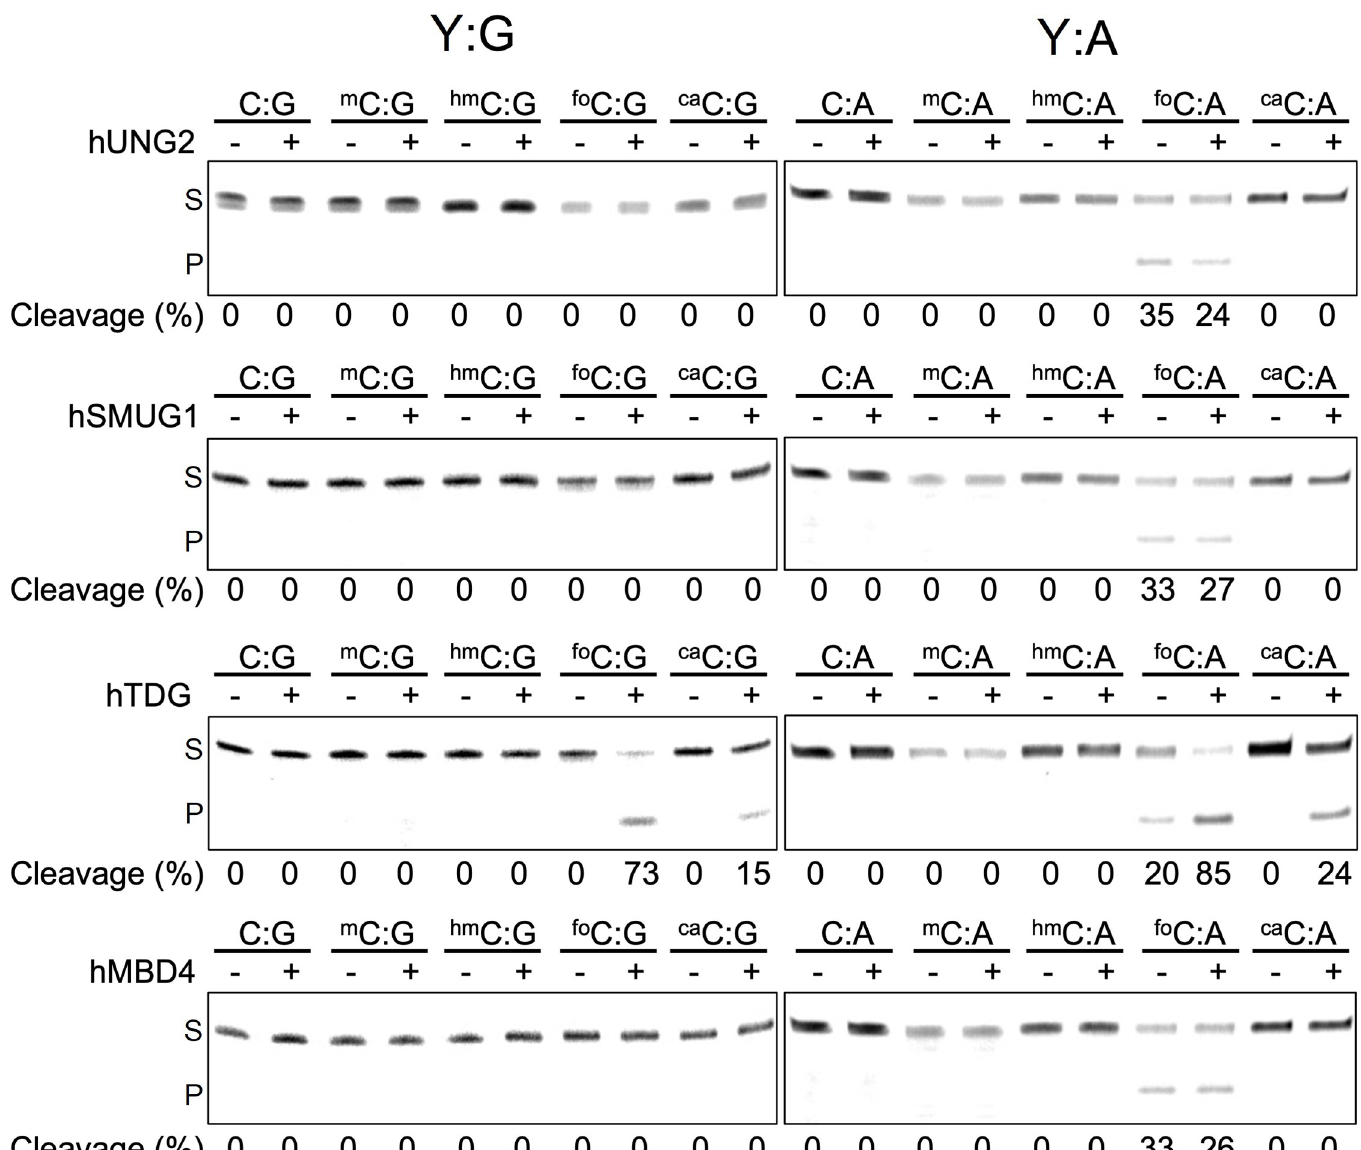
Fig 4. The excision specificity of human uracil family glycosylases for a series of 5-substituted cytosine analogs (Y) paired with G (left) or A (right). FAM-labelled oligonucleotide duplexes (2.5 pmol) in buffer appropriate for each enzyme were incubated with a glycosylase at 37˚C for 1 h. Duplexes paired with G were then incubated with hyTDG-lyase (Y163K) (65˚C, 1 h) and those paired with A incubated with NaOH solution (96˚C, 10 min) to cleave the abasic site. Oligonucleotides were resolved on a 20% polyacrylamide/urea gel, visualized on a STORM imager, and quantified with “Image quant” software. The amount of cleavage is shown below the lanes in each gel (S = substrate, P = product). Some artifact cleavage of 5foC-containing oligonucleotides is observed due to its alkaline lability. Replicate gel images are shown in S3 and S4 Fig in S1